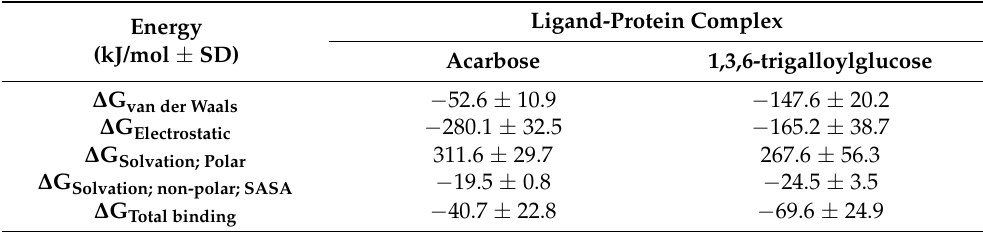
Table 3. Total binding-free energies and individual energy term of investigated gallotannin derivative and reference ligand at hMGAM substrate-binding site.